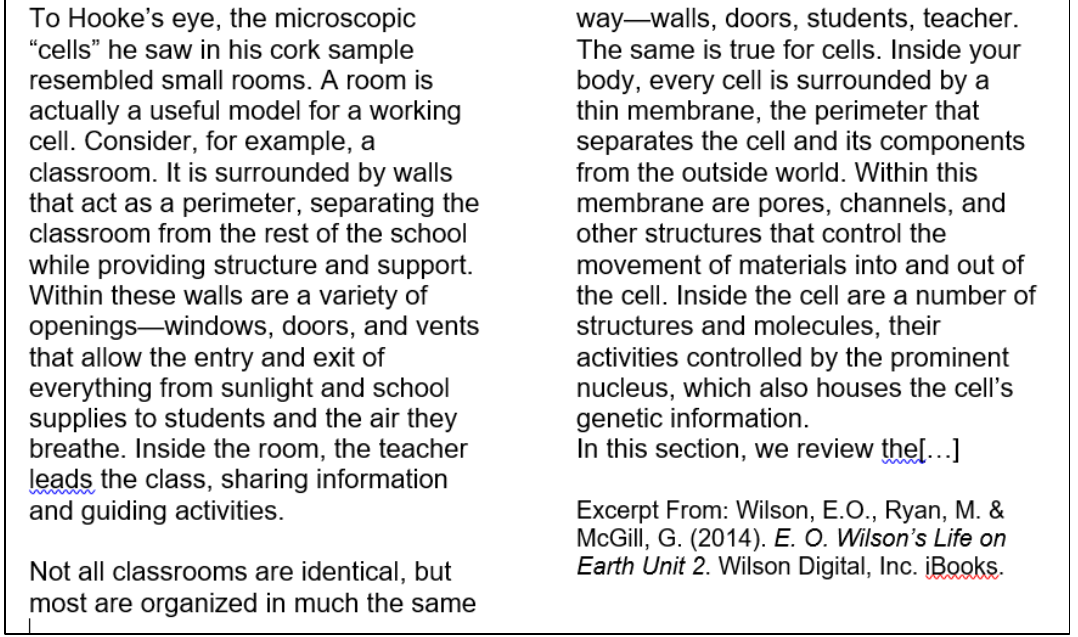
Figure 2 : Excerpt from (Wilson, et al.,